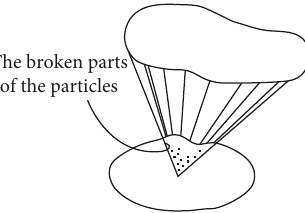
Figure 3: Physical model of particle breakage with point and surface